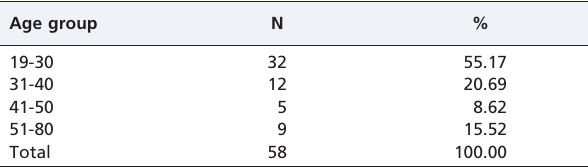
Table 1 - Distribution of the volunteers according to age